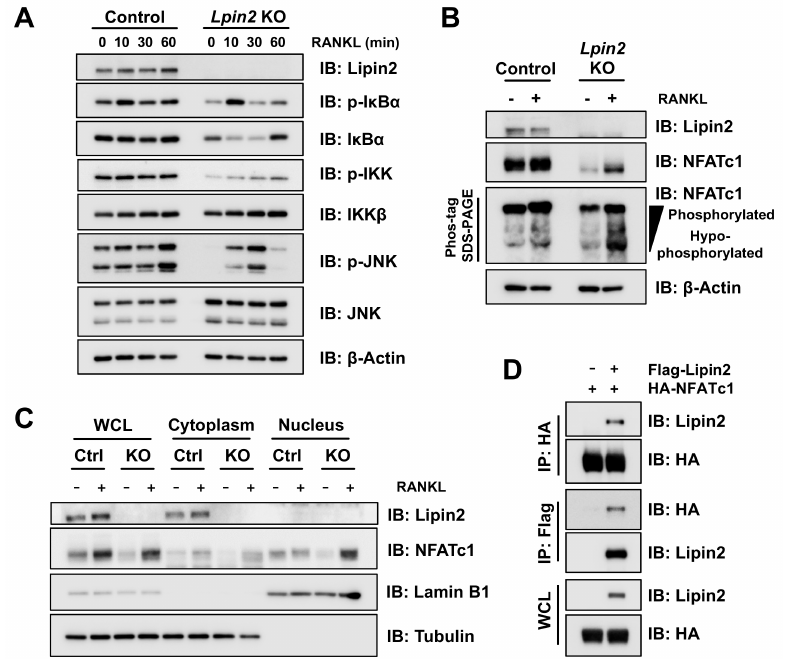
Figure 6. Lipin2 negatively regulates NFATc1 nuclear translocation in RAW-D cells. ( A ) IB analysis of WCLs derived from control (WT) and Lpin2 KO RAW-D cells treated with 50 ng/mL RANKL. The cells were harvested for IB analysis at the indicated time points. ( B ) IB analysis of WCLs derived from control and Lpin2 KO RAW-D cells treated with 50 ng/mL RANKL for 24 h. The cells were harvested for IB analysis at the indicated time points. For enhanced electrophoretic separation of phosphorylated NFATc1 species, the WCLs were resolved by Phos-tag SDS-PAGE as indicated. ( C ) IB analysis of WCL, cytoplasmic, and nuclear fractions derived from control (Ctrl) and Lpin2 KO RAW-D cells treated with 50 ng/mL RANKL for 24 h. Tubulin and Lamin B1 are shown as markers of cytoplasm and nucleus, respectively. ( D ) IB analysis of WCLs and anti-HA/anti-Flag IPs derived from 293T cells transfected with the indicated expression